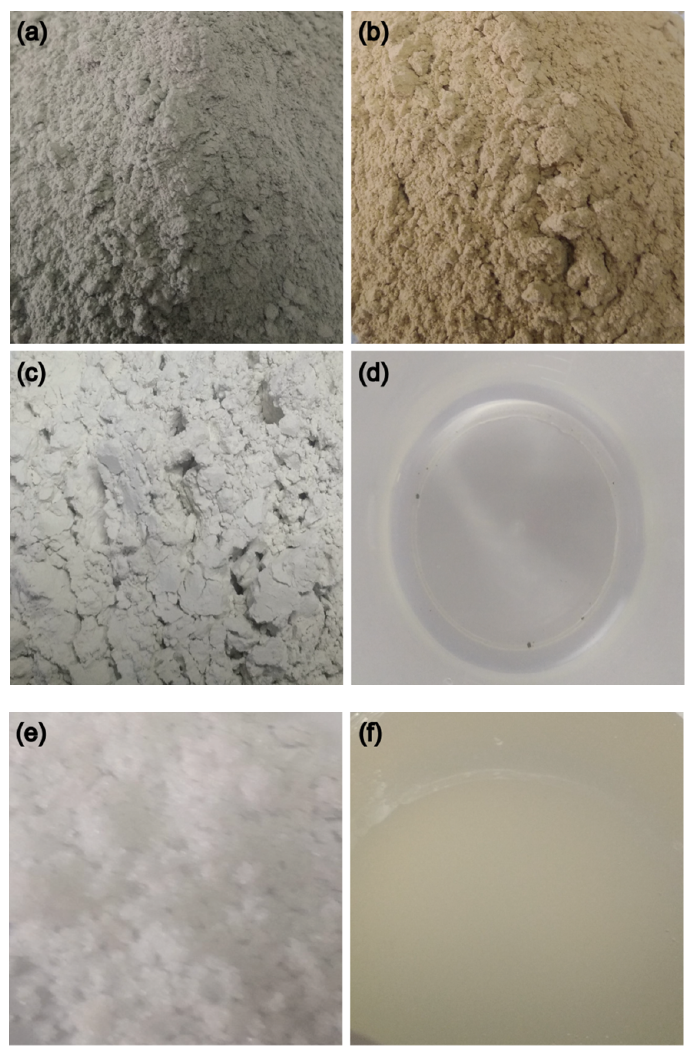
Figure 2. The main components of the high ground temperature grouting slurry (HGTGS). ( a ) The main components of group agent A. ( a ) Ordinary Portland cement; ( b ) bentonite; ( c ) slag powder; ( d ) tap water. ( b ) The main components of group agent B. ( e ) Modified additives; ( f ) sodium silicate slurry. Table 2. The chemical compositions of the HGTGS.